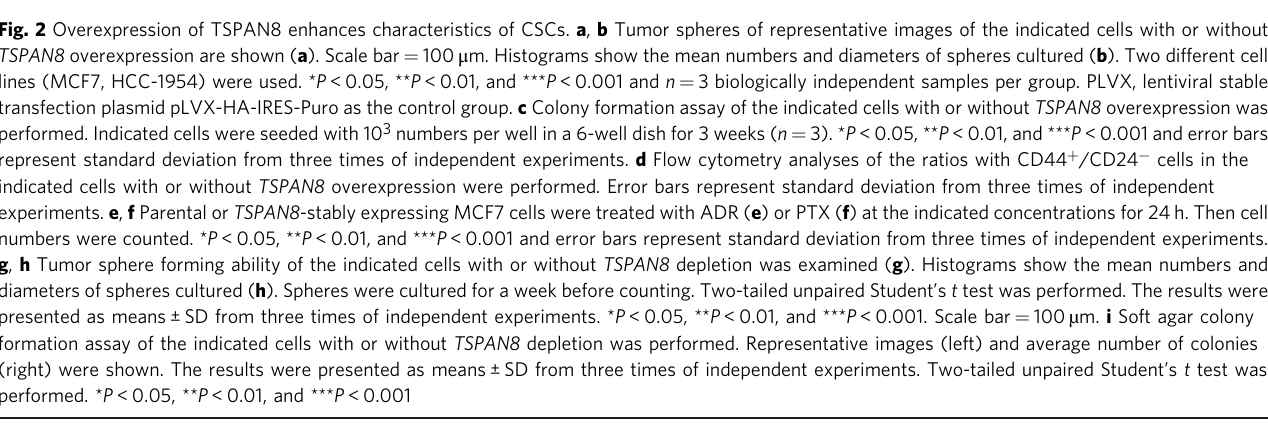
Fig. 2 Overexpression of TSPAN8 enhances characteristics of CSCs. a , b Tumor spheres of representative images of the indicated cells with or without TSPAN8 overexpression are shown ( a ). Scale bar = 100 μ m. Histograms show the mean numbers and diameters of spheres cultured ( b ). Two different cell lines (MCF7, HCC-1954) were used. * P < 0.05, ** P < 0.01, and *** P < 0.001 and n = 3 biologically independent samples per group. PLVX, lentiviral stable transfection plasmid pLVX-HA-IRES-Puro as the control group. c Colony formation assay of the indicated cells with or without TSPAN8 overexpression was performed. Indicated cells were seeded with 10 3 numbers per well in a 6-well dish for 3 weeks ( n = 3). * P < 0.05, ** P < 0.01, and *** P < 0.001 and error bars represent standard deviation from three times of independent experiments. d Flow cytometry analyses of the ratios with CD44 + /CD24 − cells in the indicated cells with or without TSPAN8 overexpression were performed. Error bars represent standard deviation from three times of independent experiments. e , f Parental or TSPAN8 -stably expressing MCF7 cells were treated with ADR ( e ) or PTX ( f ) at the indicated concentrations for 24 h. Then cell numbers were counted. * P < 0.05, ** P < 0.01, and *** P < 0.001 and error bars represent standard deviation from three times of independent experiments. g , h Tumor sphere forming ability of the indicated cells with or without TSPAN8 depletion was examined ( g ). Histograms show the mean numbers and diameters of spheres cultured ( h ). Spheres were cultured for a week before counting. Two-tailed unpaired Student ’ s t test was performed. The results were presented as means ± SD from three times of independent experiments. * P < 0.05, ** P < 0.01, and *** P < 0.001. Scale bar = 100 µ m. i Soft agar colony formation assay of the indicated cells with or without TSPAN8 depletion was performed. Representative images (left) and average number of colonies (right) were shown. The results were presented as means± SD from three times of independent experiments. Two-tailed unpaired Student ’ s t test was performed. * P < 0.05, ** P < 0.01, and *** P <